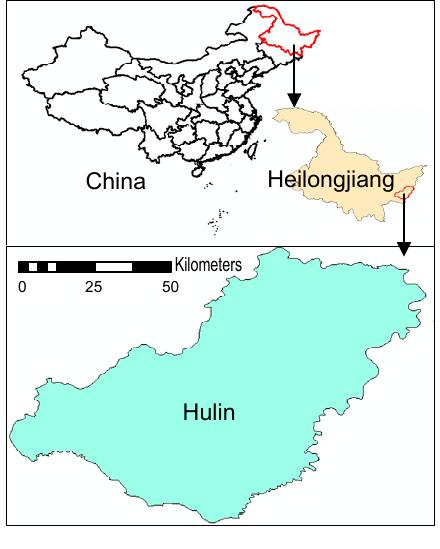
Figure 1. Study Figure 1. Study area.